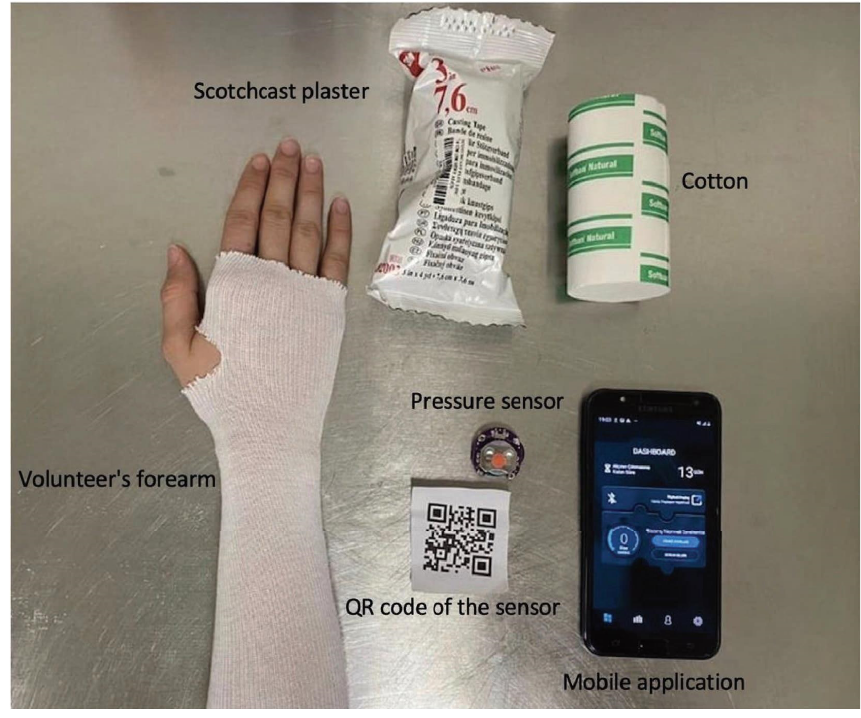
Figure 1: Materials required for skin-cast contact surface pressure